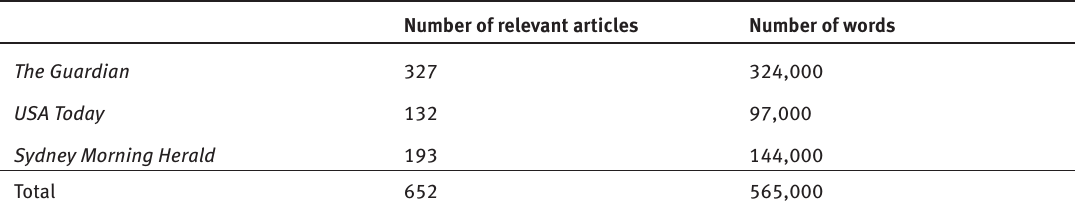
Table 1: The corpus of online newspapers